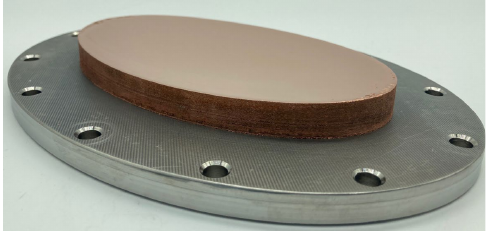
Fig. 7. 3D printed miter mirror assembly